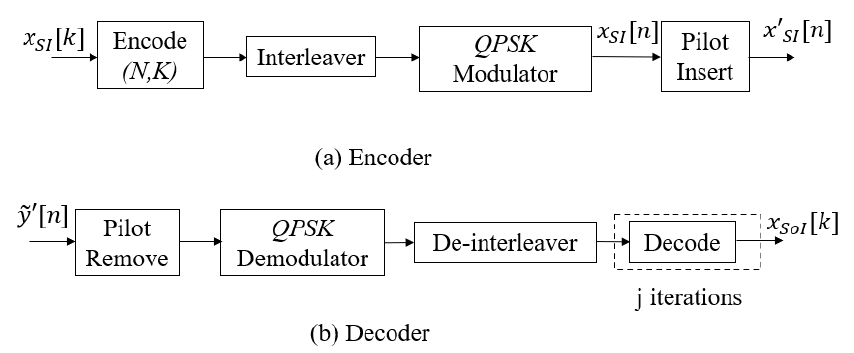
Figure 2. Encoder and decoder